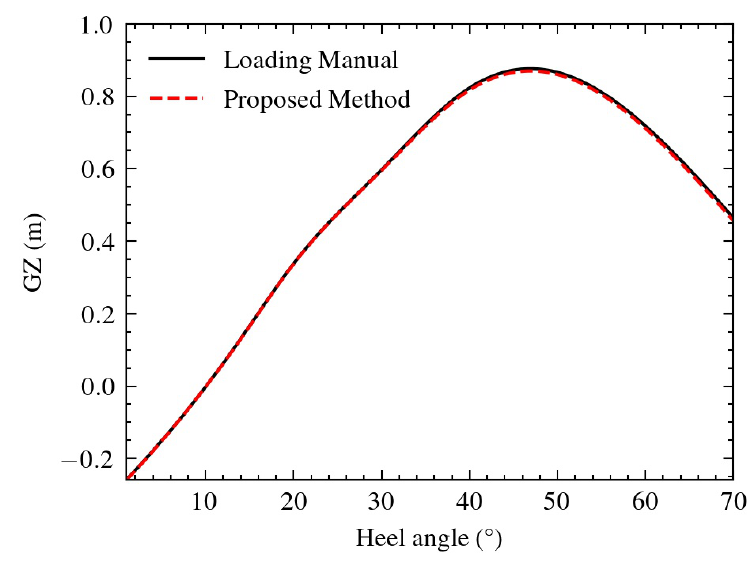
Figure 11. GZ curve of INI01-DAM08.